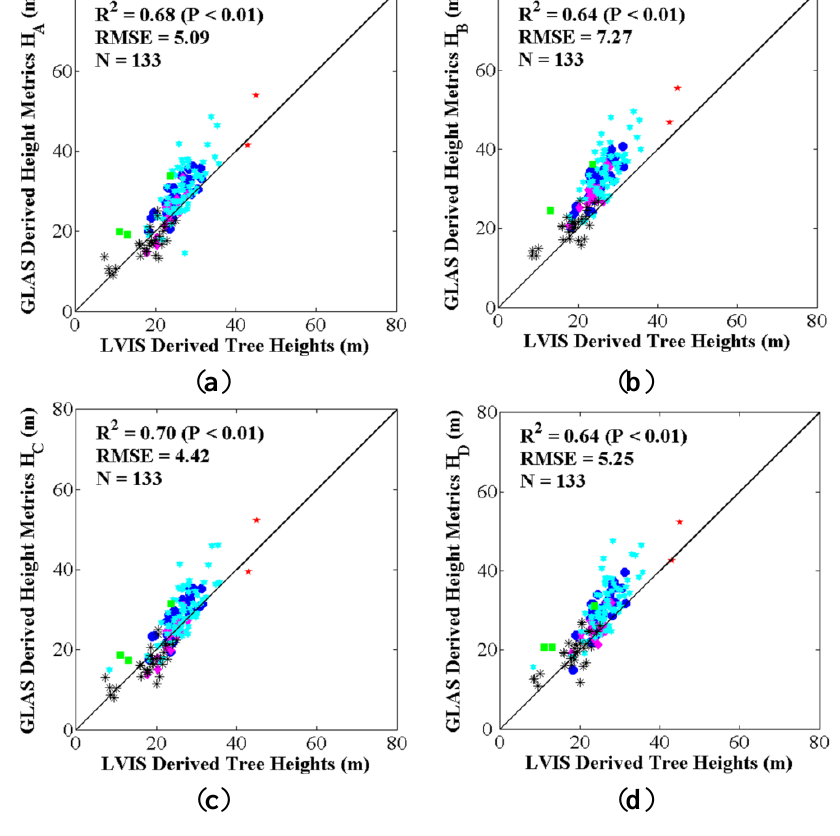
; Table 4) with LVIS tree A-E